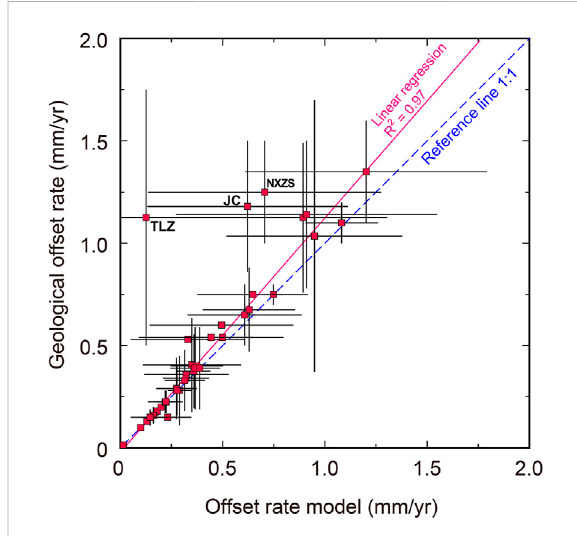
FIGURE 5 Offset rates of preferred model versus geological fault slip rate. (The vertical and horizontal black error bars represent uncertainties of published slip rates and preferred model, respectively.Thedashlineisthereferencelinewithslopeof1. Thepinklinerepresentsthelinearregressionresultofmodeloffset rate sand geological rate, except for the Tieluzi Fault (TLZ), the Jiaocheng Fault (JC) and the North Xizhoushan Fault